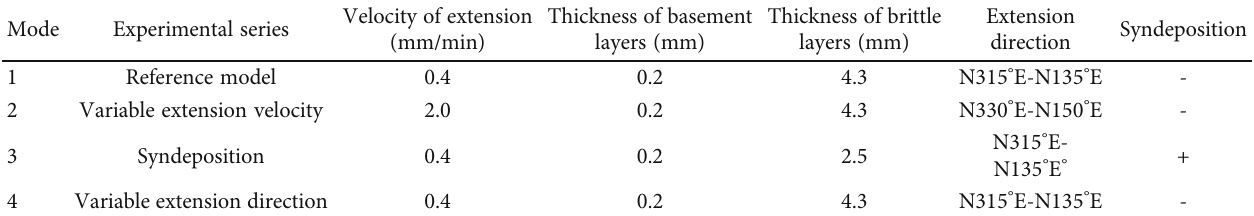
Table 1: Parameter table of each sand box simulation experiment